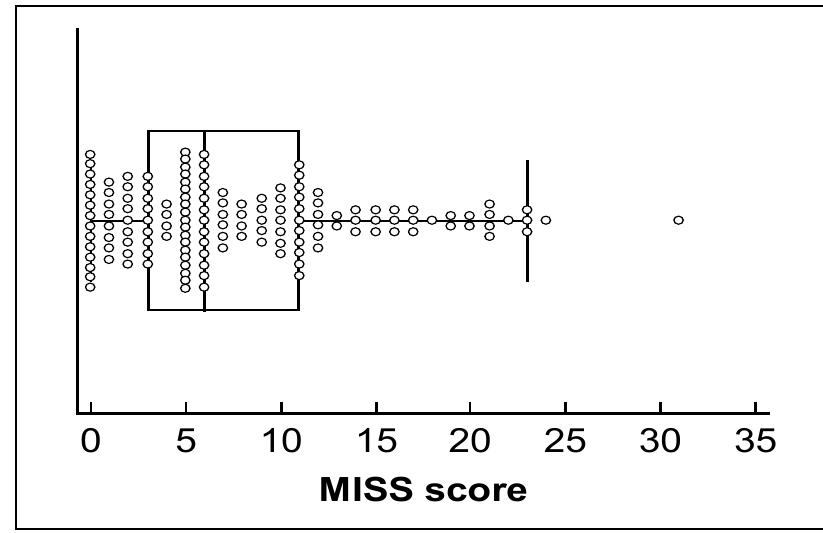
Figure 4. Distribution of total MISS scores in JIA patients. The MISS score was from 0 to 36 points.